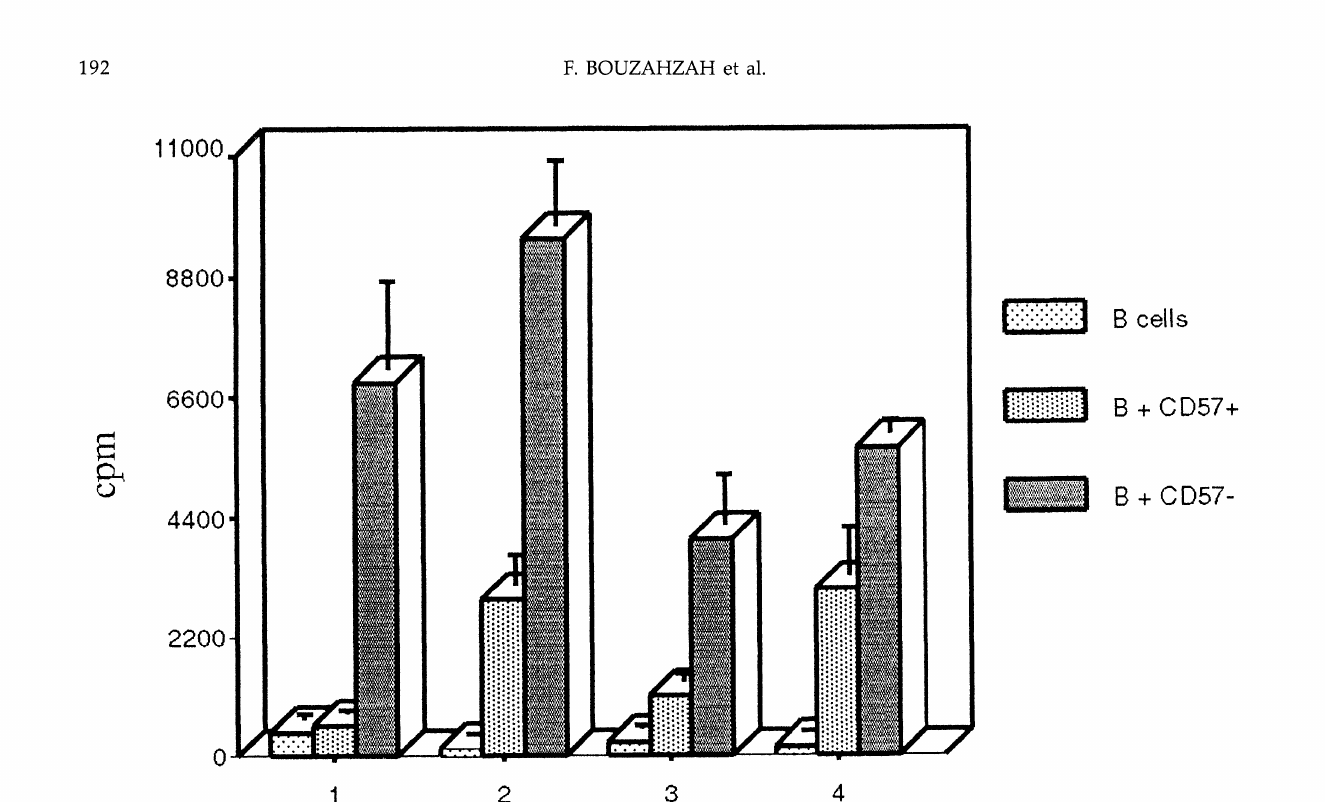
FIGURE 3. Proliferation of B cells in presence of CD57 or CD57- cells and different activators. B cells (105 cells/well) were cocultured with mitomycin-C-treated T cells (3 x 105 cells/well). Tritiated thymidin incorporation was measured after 48 hours. No or very low proliferative activity was observed in B cells cultured alone or in mitomycin-C-treated T-cell populations. T cells (CD57 or CD57-) were activated with PHA (2 g/ml) or Con A (10 g/ml) combined or not to IL-2 (10 U/ml): 1: PHA; 2: PHA and IL-2; 3: ConA; 4: ConA and IL-2. These results are representative of 3 experiments performed and are expressed as the mean of quadriplicate cultures.